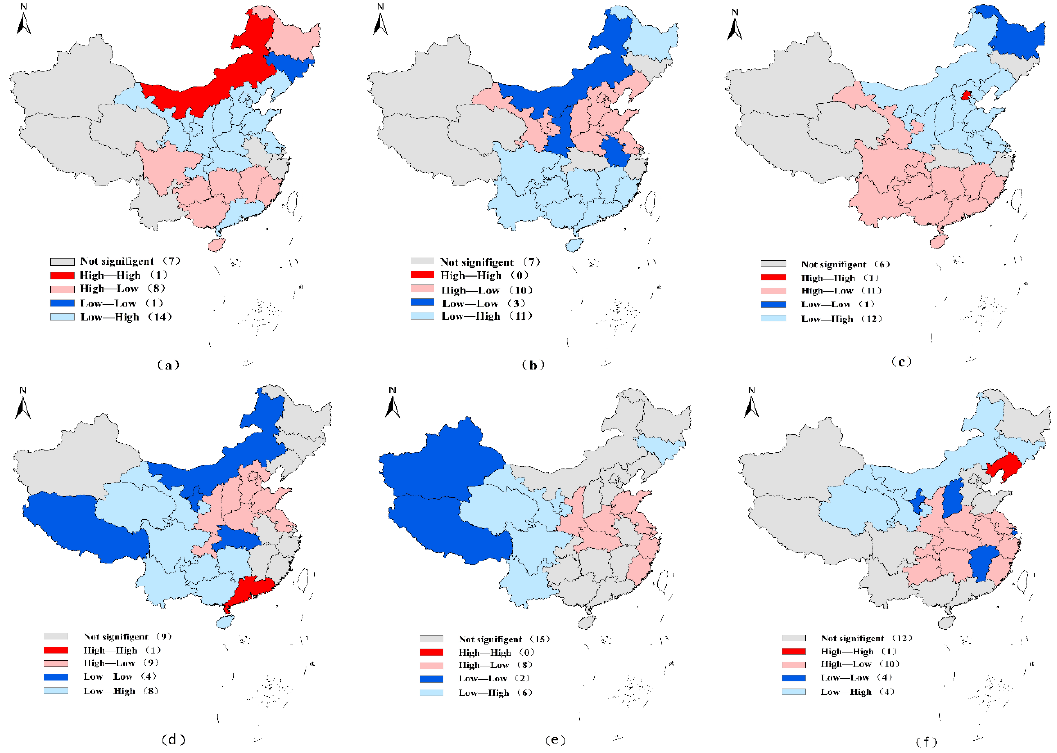
Figure 8. LISA cluster map of ( a ) per capita water resources, ( b ) water resources utilization rate, ( c ) river water quality index, ( d ) comprehensive output value per cubic meter of water, ( e ) per capita R&D funding, ( f ) and per capita water environment investment.